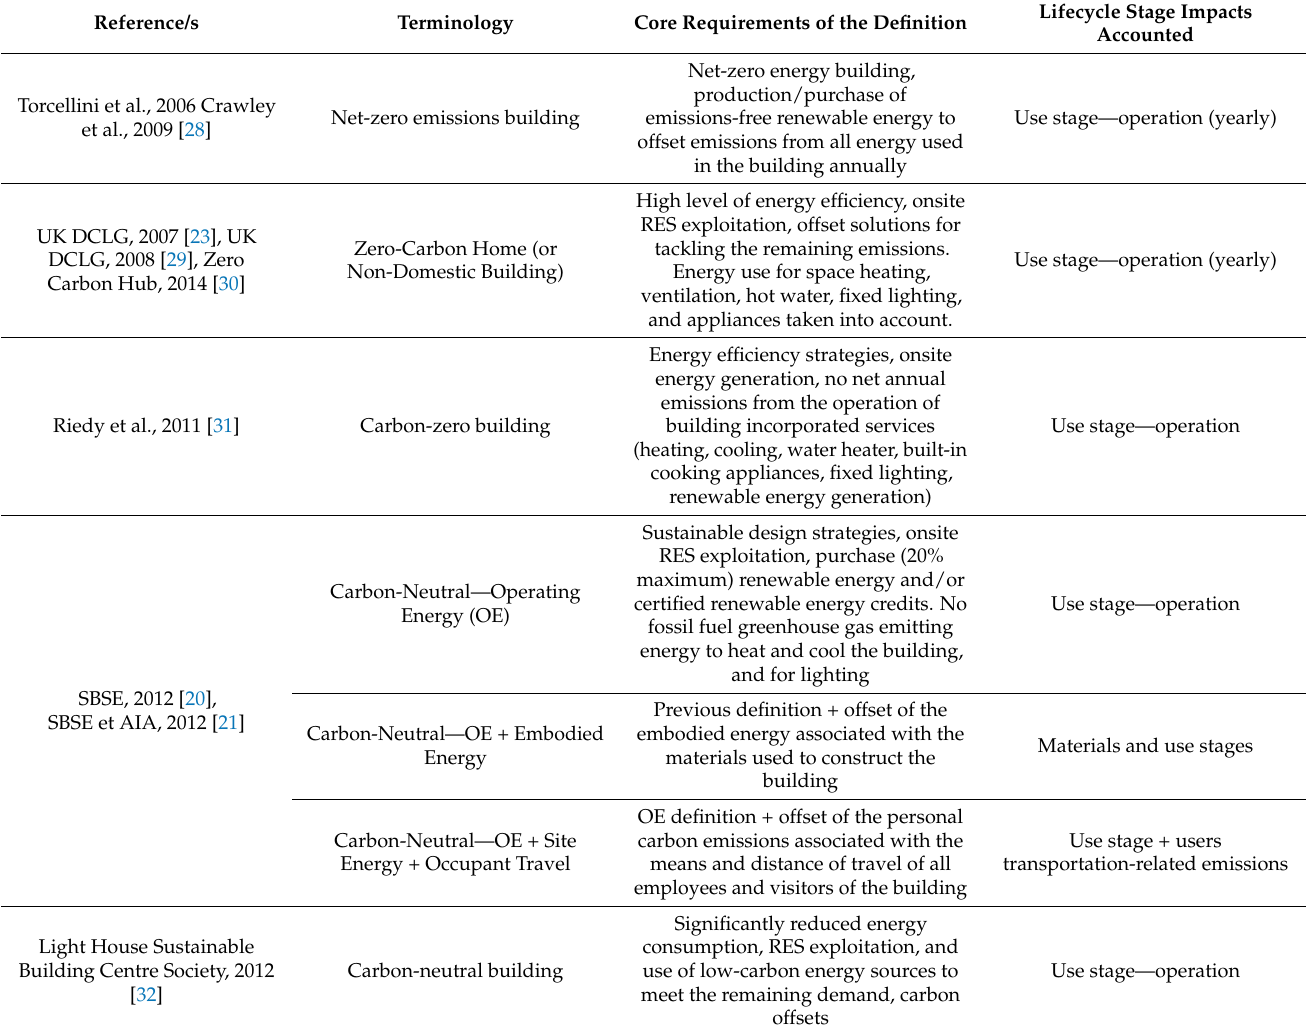
Table 1. Summary of CNB/ZCB definitions, core requirements of the definition, and accounted emissions. Please note that the abbreviation “RES” stands for renewable energy